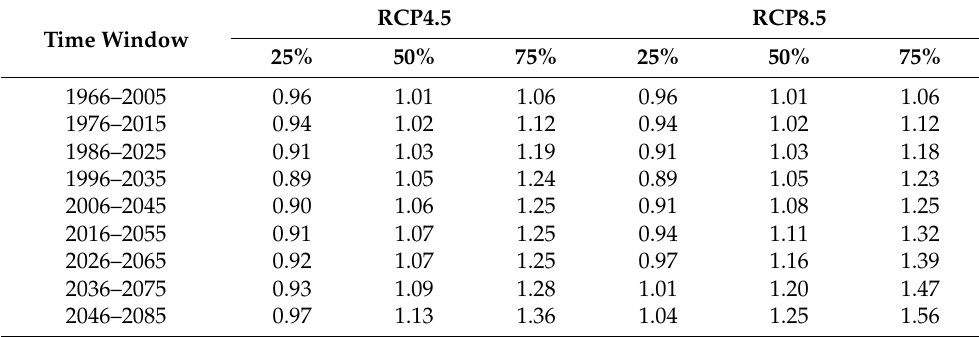
Table 5. Mean of factors of change percentiles for p r,k in the investigated region. Time Window